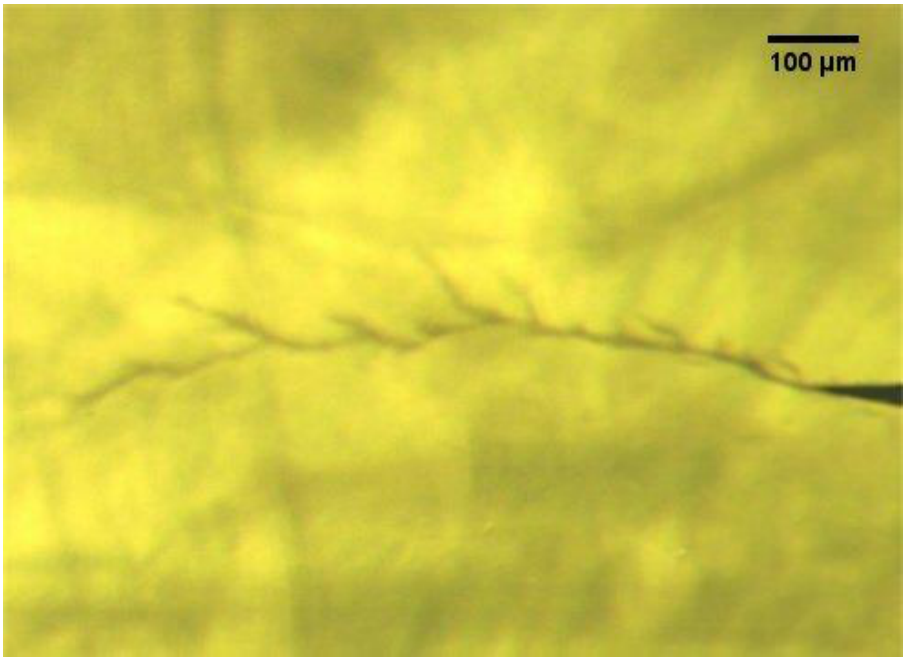
Figure 6. Electrical tree developed at positive voltage with firing angle of 0 degrees.